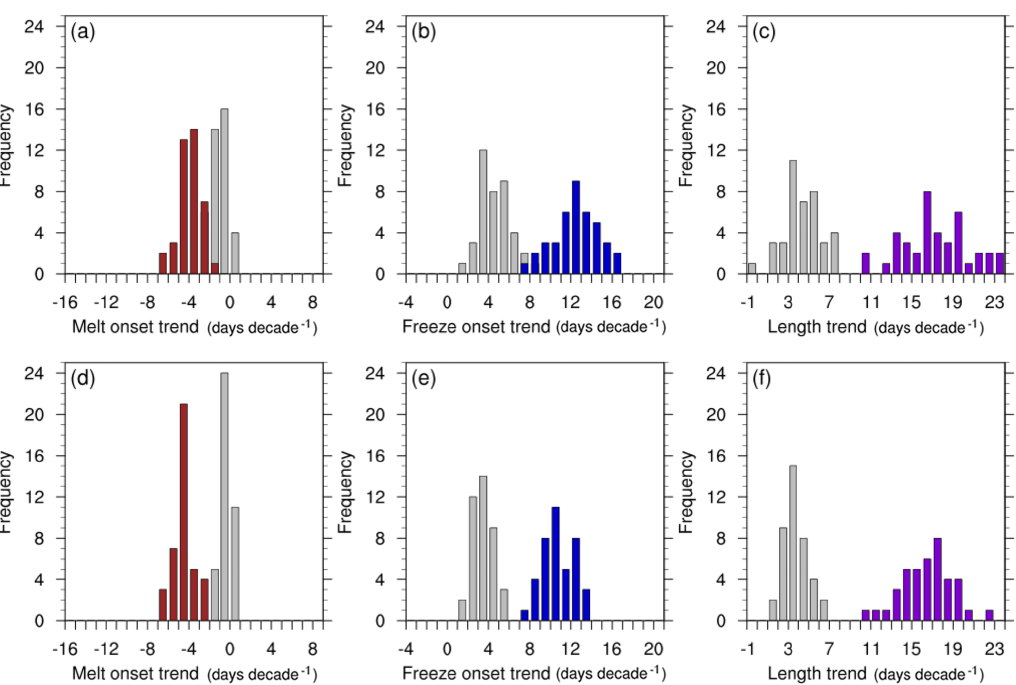
Figure 14. Histograms of the pan-Arctic trends in melt season characteristics for 1979–2014 (shaded in gray) and for the end of the 21st century (2064–2099, shaded in red for melt onset, blue for freeze onset and purple for melt season length). This shows the change in the trends over the 21st century as well as the changing impact of internal variability on these trends. The histograms use the surface temperature definitions (a–c) and thermodynamic ice volume tendency definitions (d–f) for all 40 CESM LE ensemble members. Note that the x -axis range is the same (25daysdecade − 1 ) for all panels shown in this figure, but different from Fig.